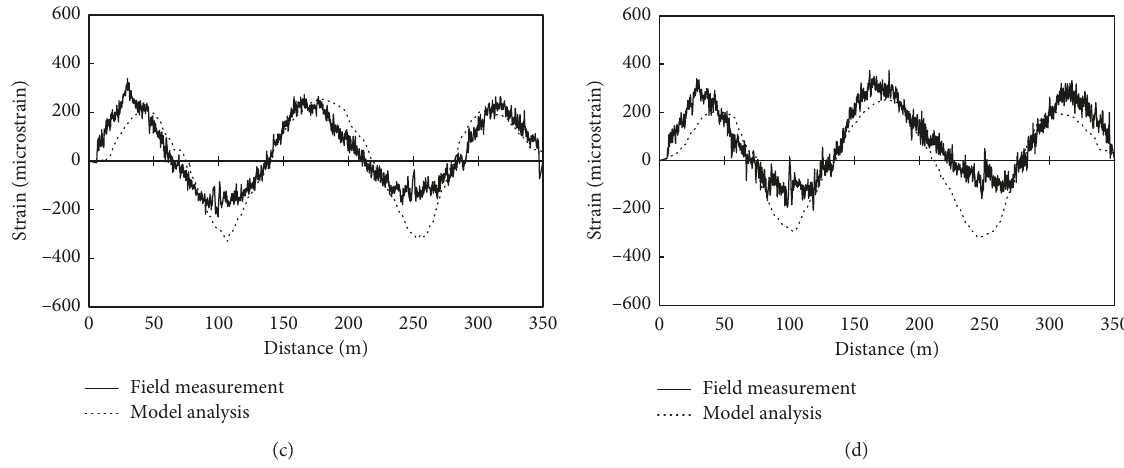
Figure 9: Comparison of the measured and simulated strains of lines 1–4. (a) Line 1. (b) Line 2. (c) Line 3. (d) Line